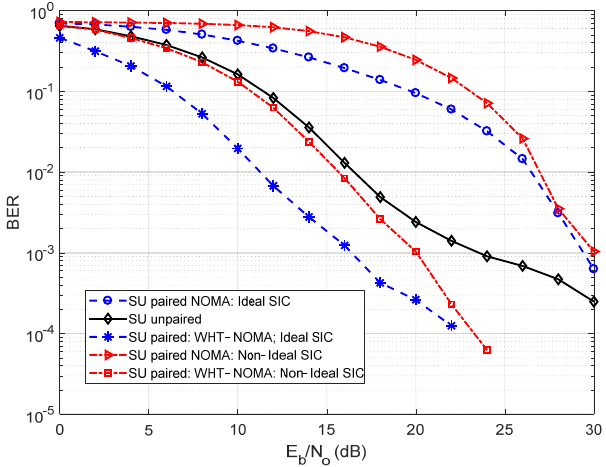
Figure 8. BER performance using QAM modulation; NOMA vs. WHT–NOMA, power allocation: